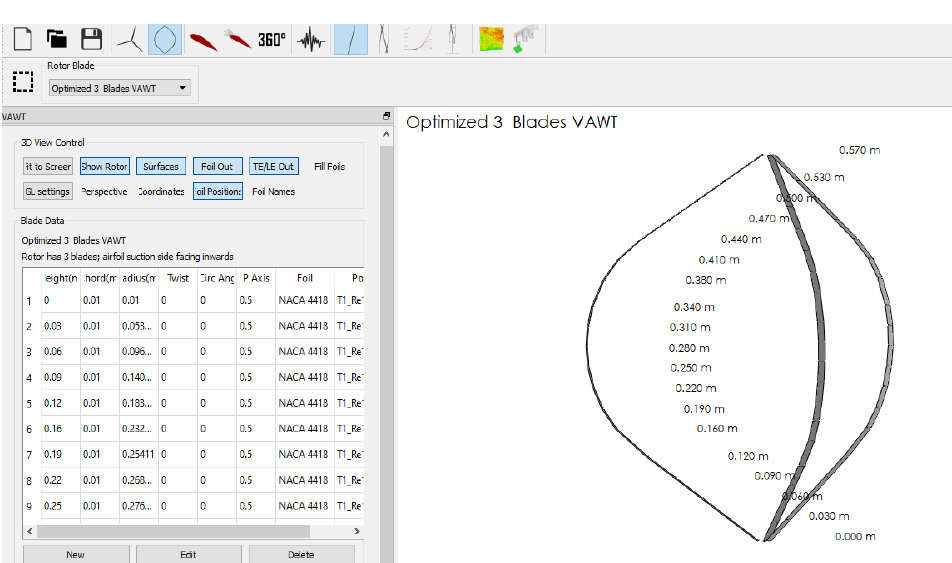
Figure 3. Design of 3 blades of VAWT.